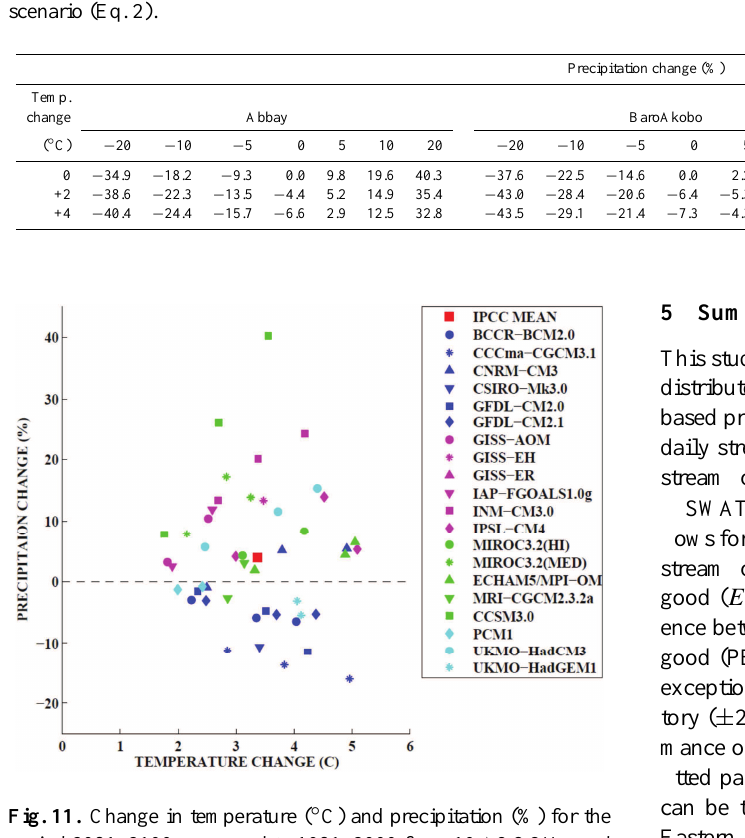
Table 9. Percentage change in simulated average annual streamflow for each of twenty climate change scenarios compared with the baseline scenario (Eq. 2).